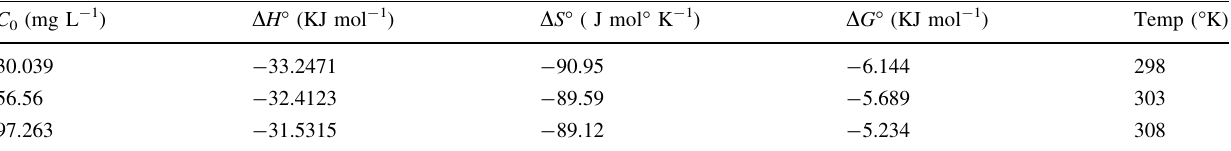
Table 4 Thermodynamic parameters for Cd(II) biosorption on A. heterophylla C 0 (mg L - 1 )